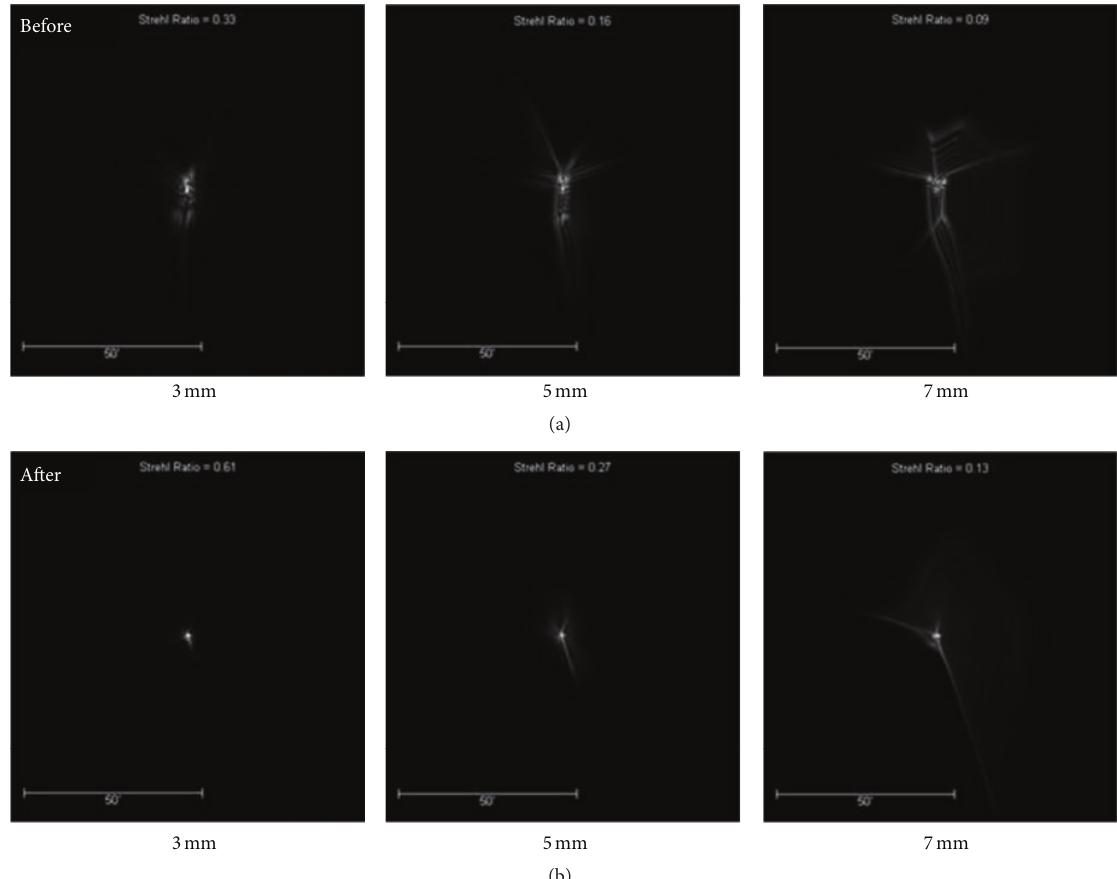
Figure 3: The PSF image of one patient receiving treatment with artificial tear drops. The patterns of (a) denote the results before treatment, while those of (b) denote the results after